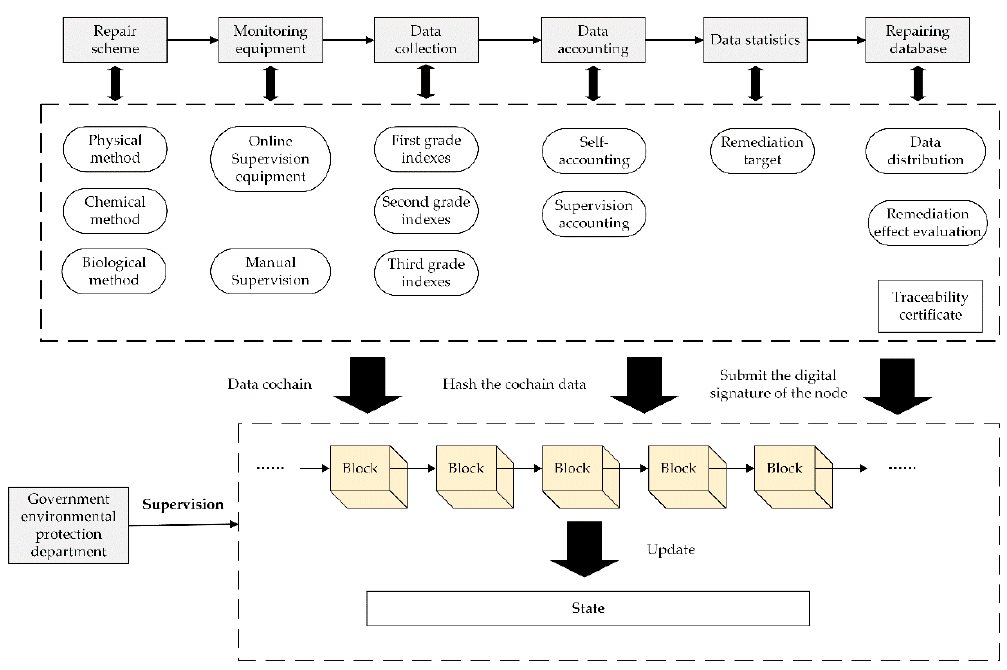
Figure 6. Supervision alliance